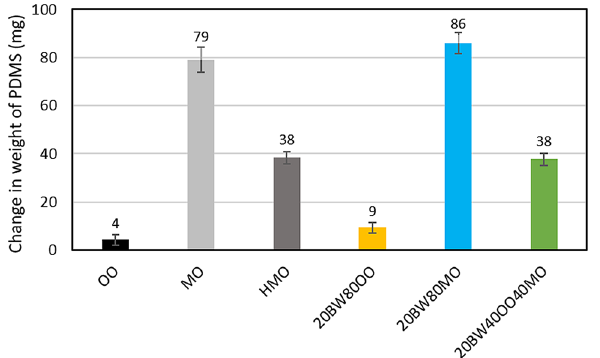
Figure 6. Change in weight of PDMS four hours after the application of lubricants. BW stands for beeswax, PW is paraffin wax, OO is olive oil, MO is mineral oil (light), and HMO is heavy mineral oil. As a naming convention for the various mixtures, the weight percent of each component is listed in front of the specific component, e.g., 20BW80MO represents a 20 wt% beeswax and 80 wt% mineral oil